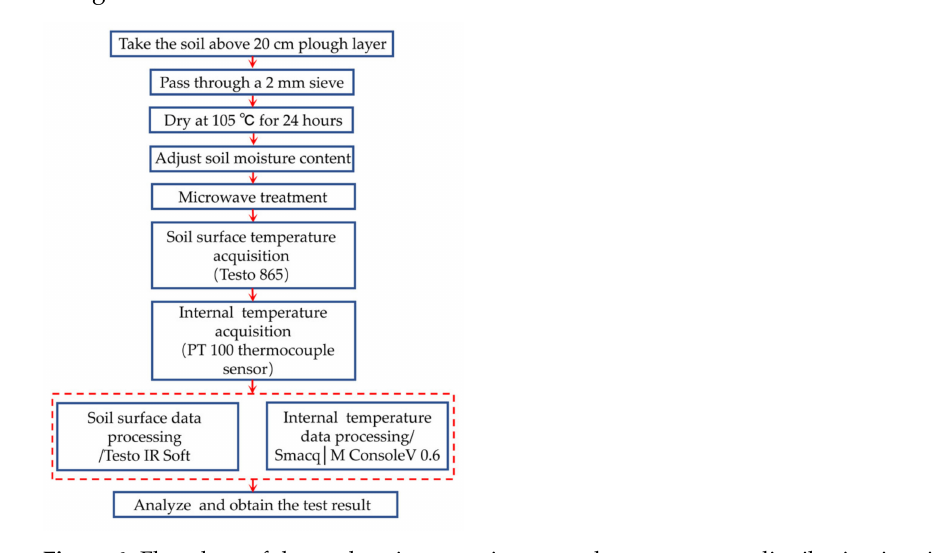
Figure 6. Flowchart of the exploration experiment on the temperature distribution in microwave- treated